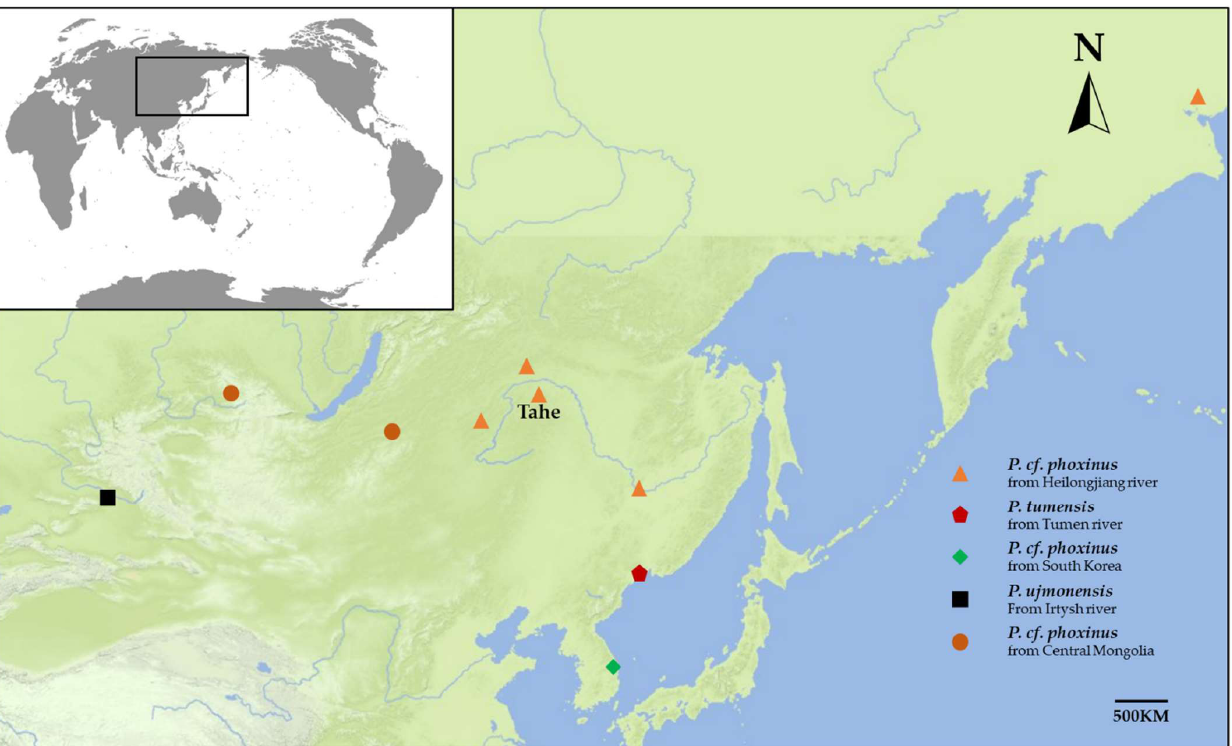
Figure 1. The sampling sites of Eurasian minnows ( Phoxinus spp.) mitochondrial lineages in Asia. Triangles represent Phoxinus cf. phoxinus from the Heilongjiang River; Pentagon represents P. tumensis from Tumen River; Diamond represents the Phoxinus cf. phoxinus from South Korea; Solid circles represent Phoxinus cf. phoxinus from Mongolian Plateau; Square represents P. ujmonensis from Irtysh River. Samples from Anadyr River (in Northeast of Russia) clustered together with Phoxinus cf. phoxinus from HLJ, indicating that this lineage may have a wide distribution.